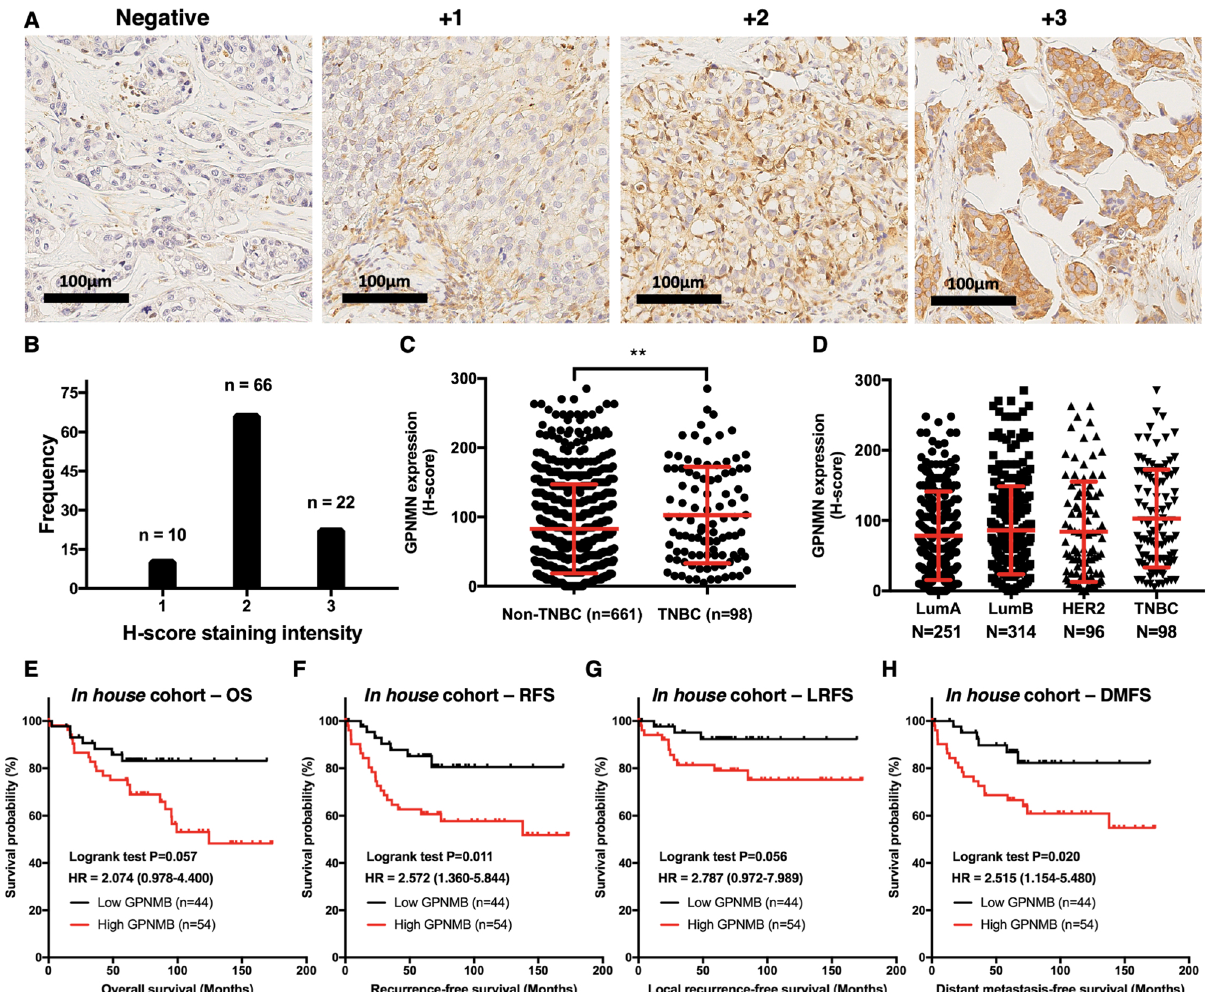
Figure 1Uploaded the correct version of figure 1. GPNMB expression in patients with triple-negative breast cancer (TNBC) is a predictor of breast cancer recurrence. ( A ) Representative immunohistochemistry pattern of GPNMB intensity graded as 0, negative-staining; 1 + , weak; 2 + , moderate and 3 + , strong. ( B ) Immunohistochemistry showing the GPNMB staining intensity among patients with TNBC. ( C ) Quantitative expression of GPNMB was compared in TNBC and non-TNBC groups. T test, ** P < 0.01. ( D ) Quantitative expression of GPNMB was compared in immunohistochemical subtypes. ( E–H ) Kaplan–Meier analysis of the influence of GPNMB protein expression on ( E ) Overall survival, OS, P = 0.057. ( F ) Recurrence-free survival, RFS, P = 0.011. ( G ) Local recurrence-free survival, LRFS, P = 0.056. ( H ) Distant metastasis-free survival, DMFS, P =